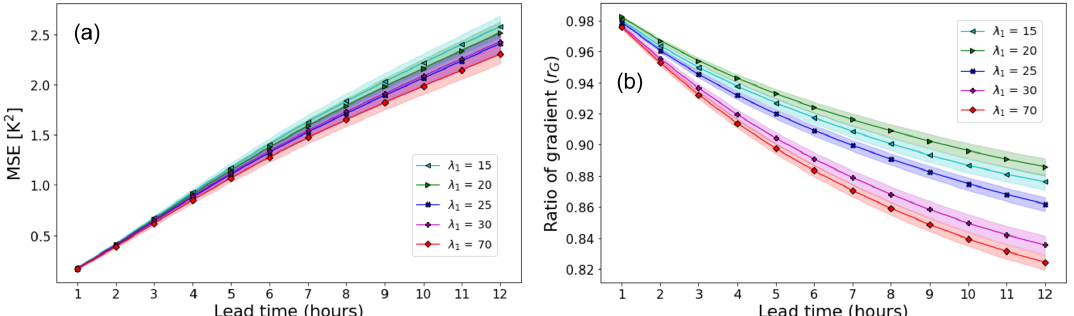
Figure 8. Performance of the SAVP model in terms of (a) MSE and (b) the gradient ratio r G with variations in the scaling factor for the L1 loss λ 1 . Note that the results for λ 1 = 70 only differ marginally from using λ 1 = =10000.